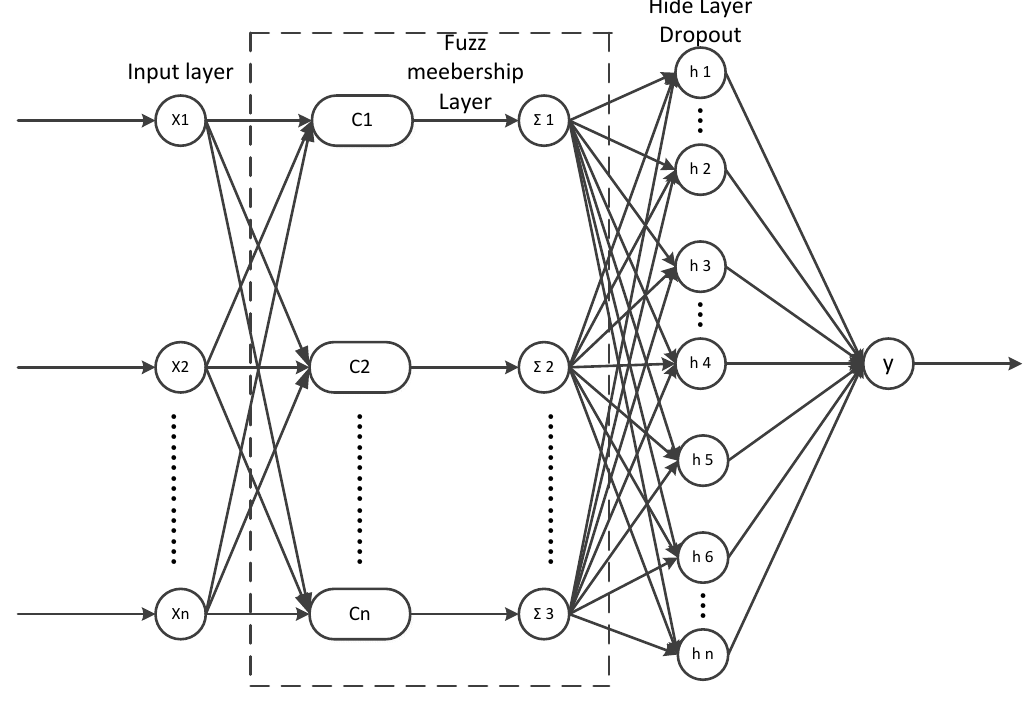
Figure 9. Structure of fuzzy neural network system.